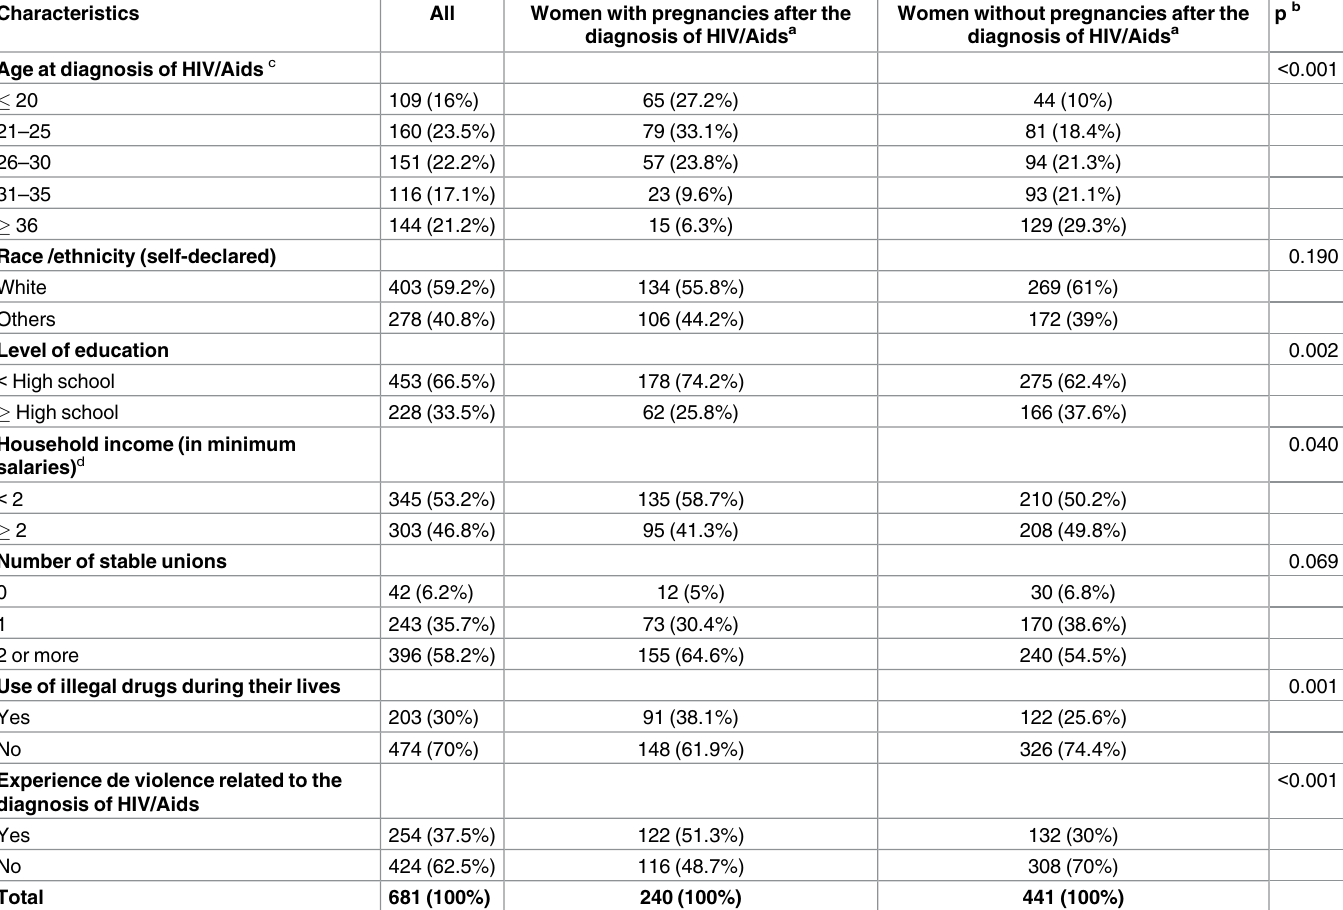
Table 1. Socioeconomic characteristics and experiencesof women living with HIV, in accordancewith the occurrence of pregnancies after diag- nosis, in Porto Alegre, 2011.